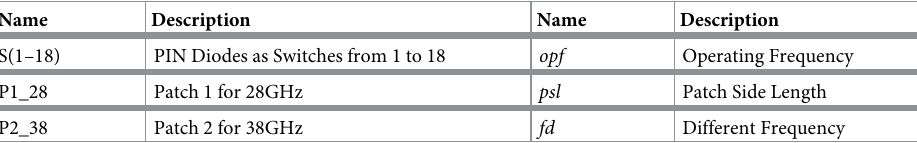
Table 2. Nomenclature of important parameters.